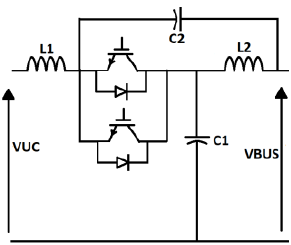
Figure 8. Two shoot-through switching devices in parallel.